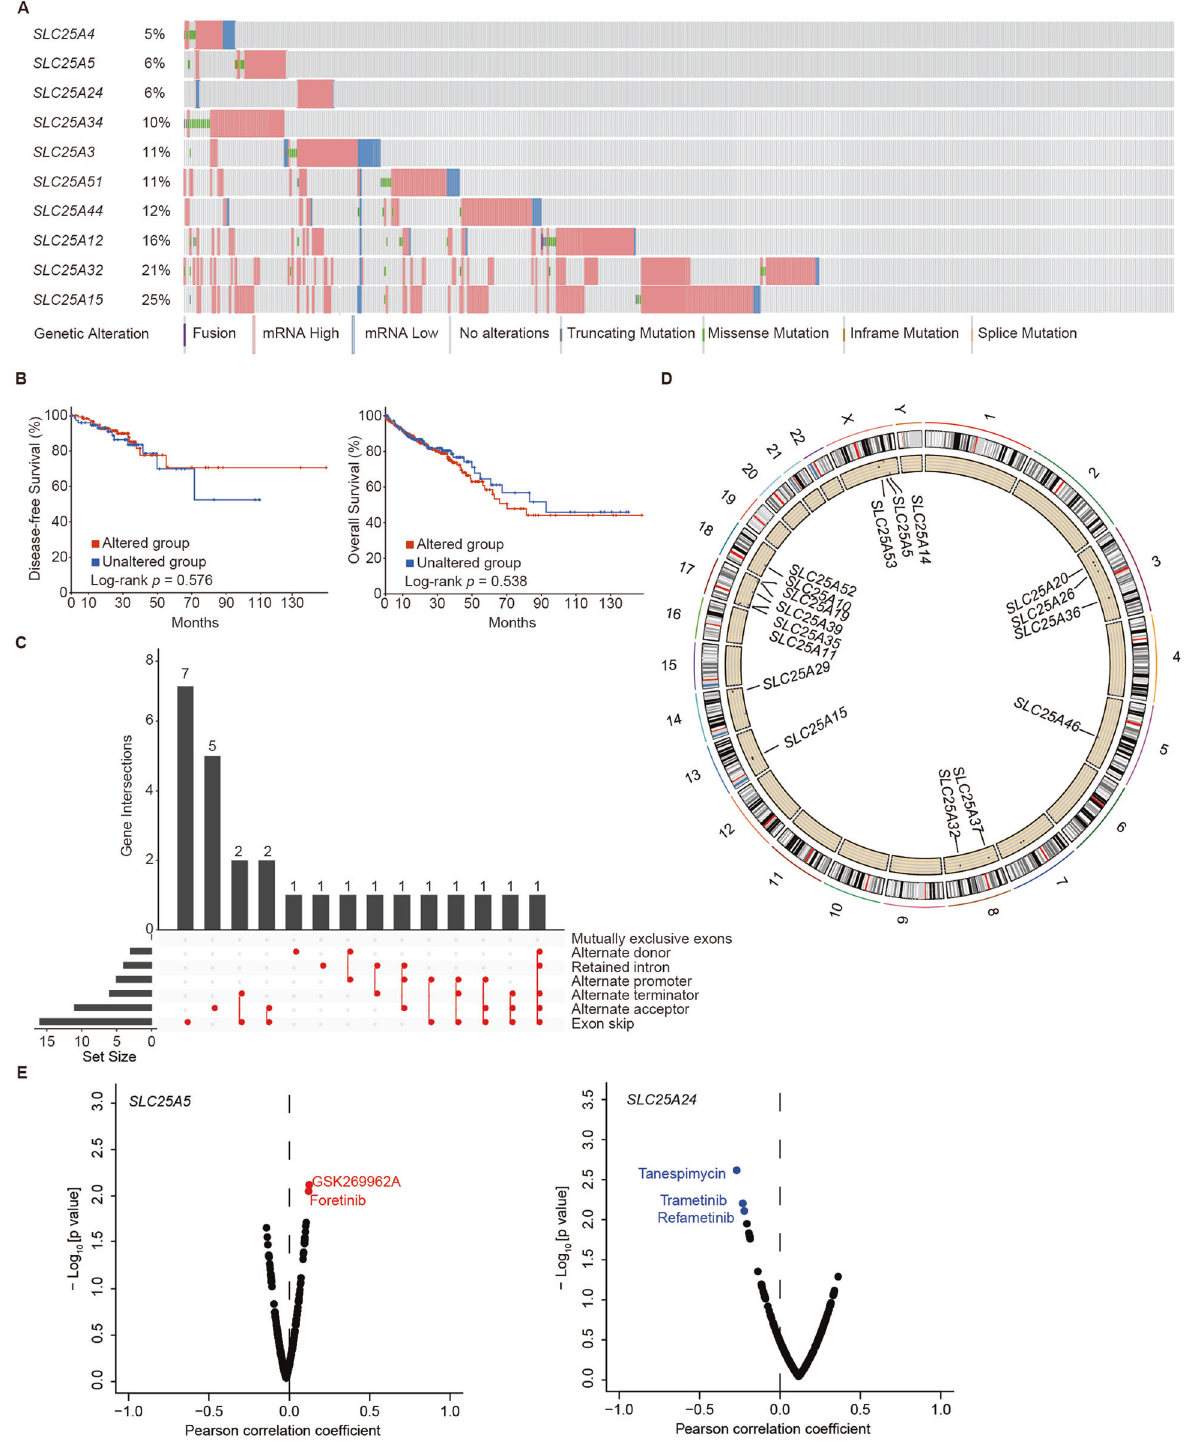
Fig. 3 The genomic and transcriptomic variations of DEMs in colon cancer. A DEMs of SLC25 with differential DNA mutation rates and mRNA expression levels in colon cancer from the TCGA dataset were identi fi ed using cBioPortal. Among them, SLC25A4, SLC25A5 , SLC25A24 , SLC25A34 , SLC25A3 , SLC25A51 , SLC25A44 , SLC25A12 , SLC25A32 , and SLC25A15 exhibited higher mutation frequencies, with rates of 5, 6, 6, 10, 11, 11, 12, 16, 21, and 25%, respectively. B No statistically signi fi cant differences in OS and disease-free survival (DFS) were observed in patients with colon cancer grouped by DNA mutation rate in the altered and unaltered groups by log-rank test, despite a longer overall survival time in the unaltered group with a lower DNA mutation frequency in DMEs of SLC25. C An UpSet diagram exhibited alternative splicing for DMEs and suggested that exon skipping was the major type of alternative splicing event. D The locations of copy number variation in DMEs of 23 SLC25 human chromosome pairs. E Patients with SLC25A5 overexpression showed a signi fi cantly high sensitivity to the ROCK inhibitor GSK269962A and to foretinib. Upregulation of SLC25A24 increased tansapimycin, trametinib, and refametinib